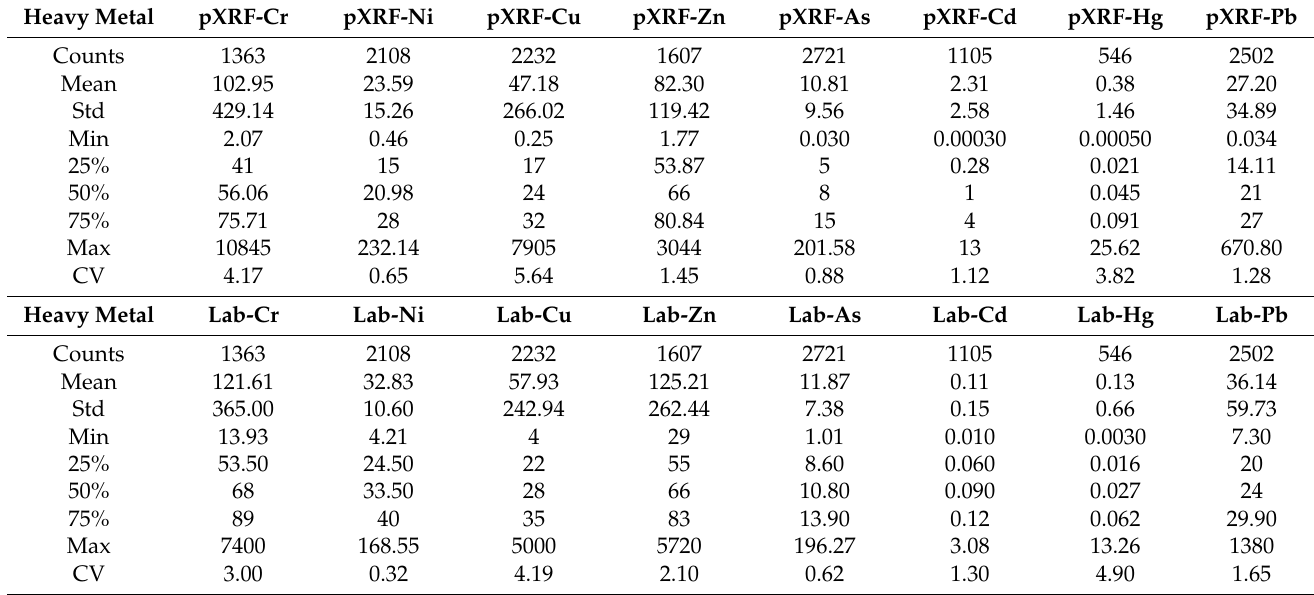
Table 2. Statistical characteristics of pXRF and laboratory-analyzed results